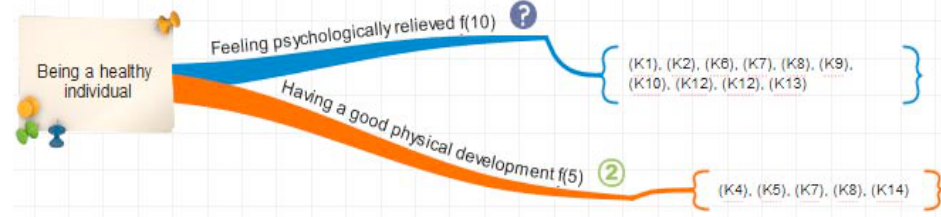
Figure 1. The category of being a healthy